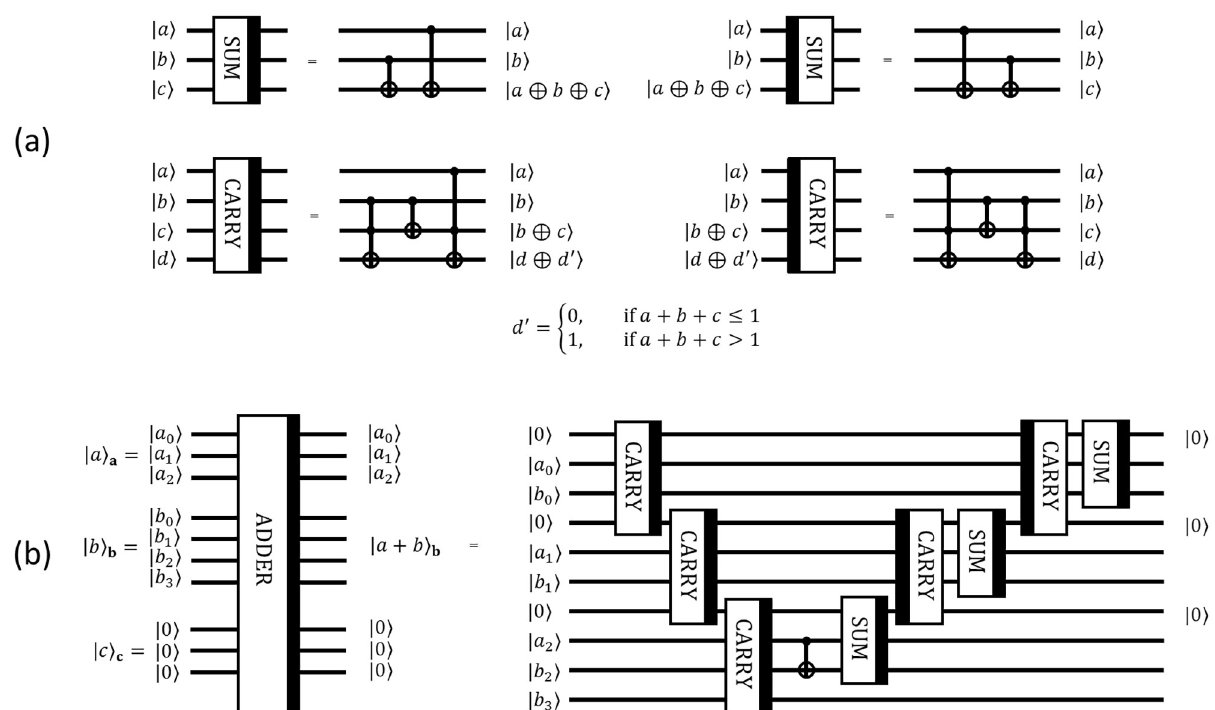
Fig 4. SUM , CARRY and ADDER decompositions. (a) Decomposition of SUM , reversed SUM , CARRY , and reversed CARRY circuits (b) Decomposition of ADDER circuit for adding two 3-bit integers a and b